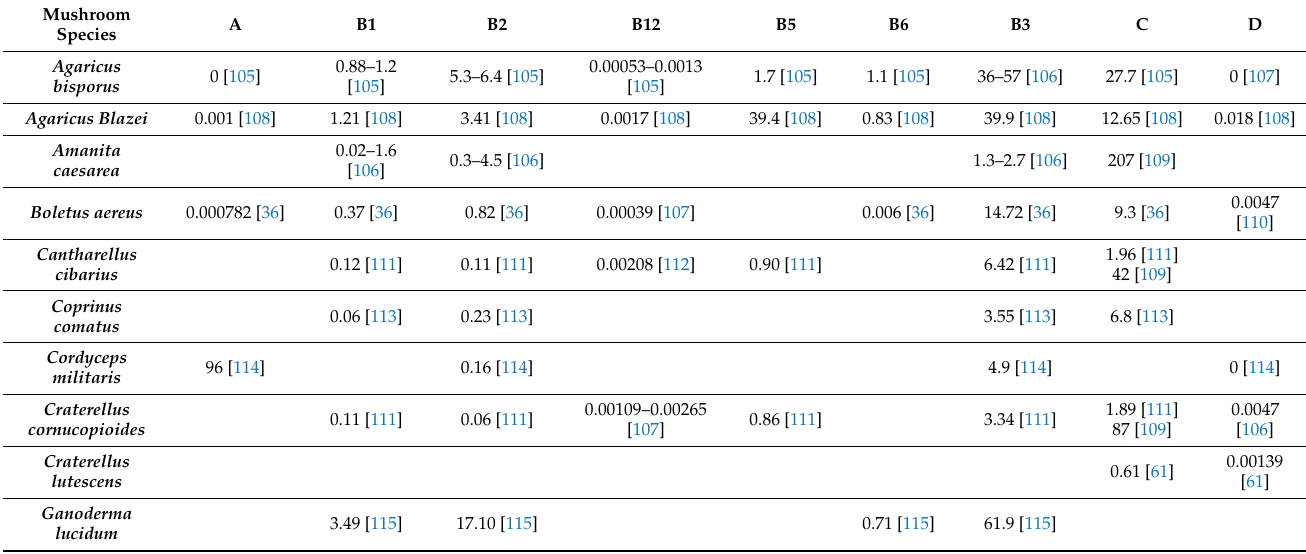
Table 2. Nutritional value of mushrooms (vitamins per 100 g